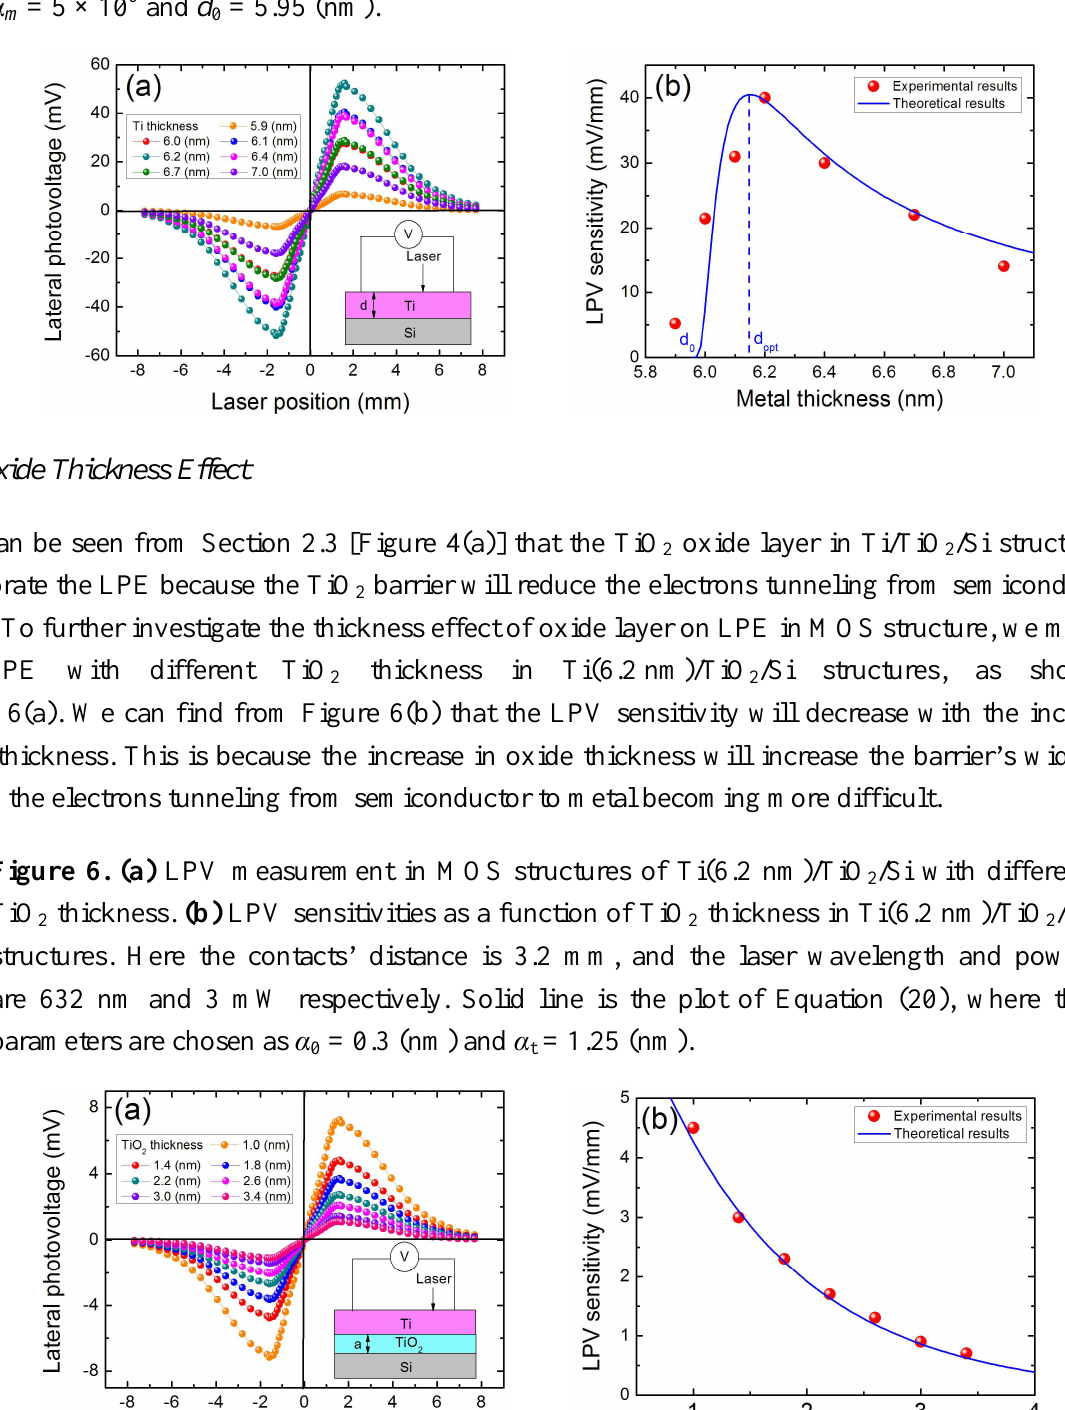
Figure 5. (a) LPV measurement in MS structures of Ti/Si with different Ti thickness. (b) LPV sensitivities as a function of Ti thickness in Ti/Si structures. Here the contacts’ distance is 3.2 mm, and the laser wavelength and power are 632 nm and 3 mW respectively. Solid line is the plot of Equation (17), where the parameters are chosen as α = 5 × 10 6 and d = 5.95 (nm). m 0